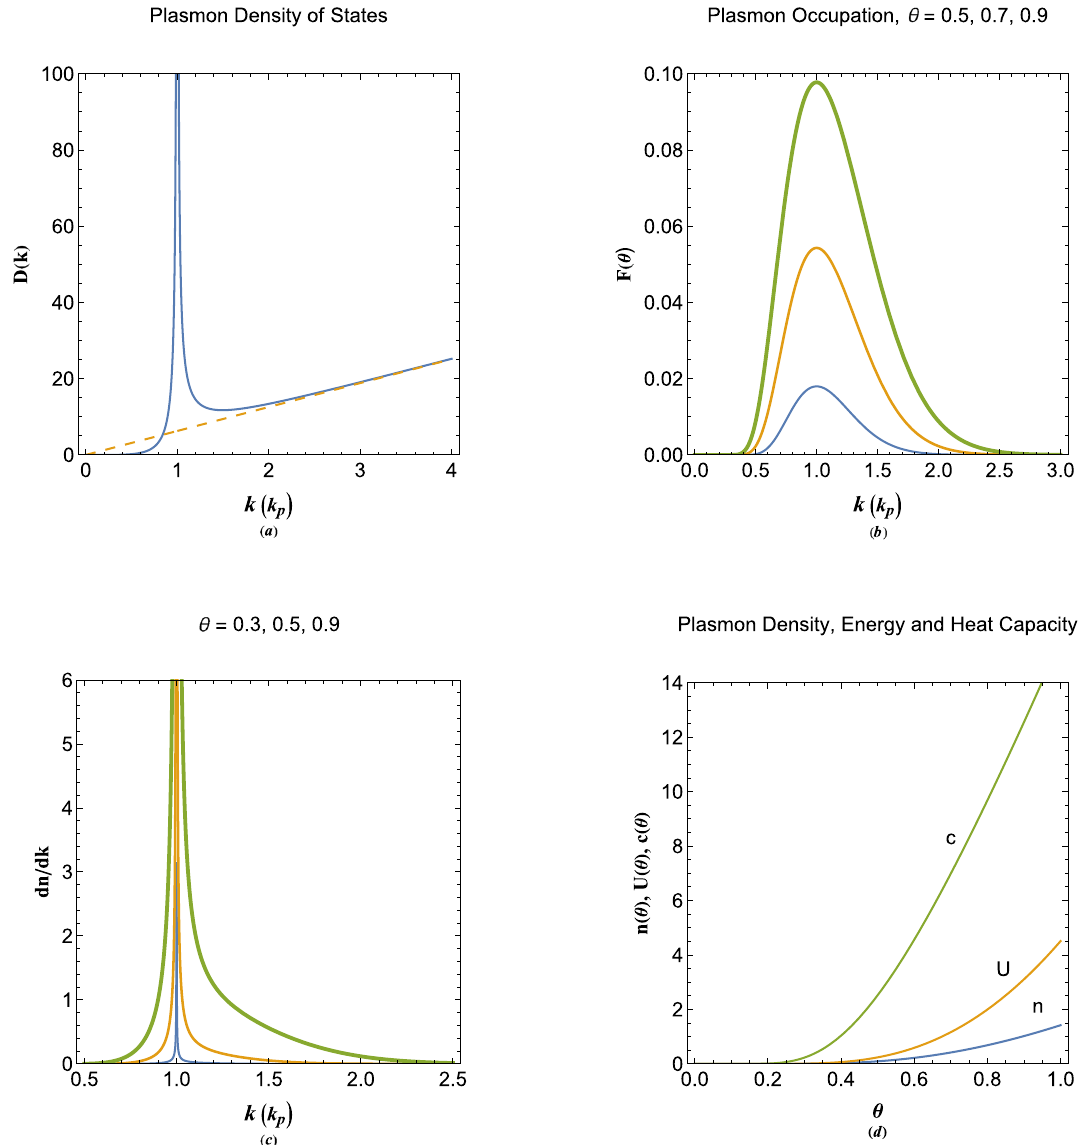
Figure 1. ( a ) The normalized plasmon density of states (DoS) as a function of the plasmon wavenumber showing a Van Hove-like singularity at the plasmon surface. ( b ) The normalized plasmon occupation function variation with the wavenumber for different normalized electron temperature. The increase in the curve thickness indicate the increase in the electron temperature. ( c ) The normalized quasiparticle mode per wavenumber for different electron temperature values. ( d ) The plasmon quasiparticle number-density, internal energy and heat capacity as a function of the electron